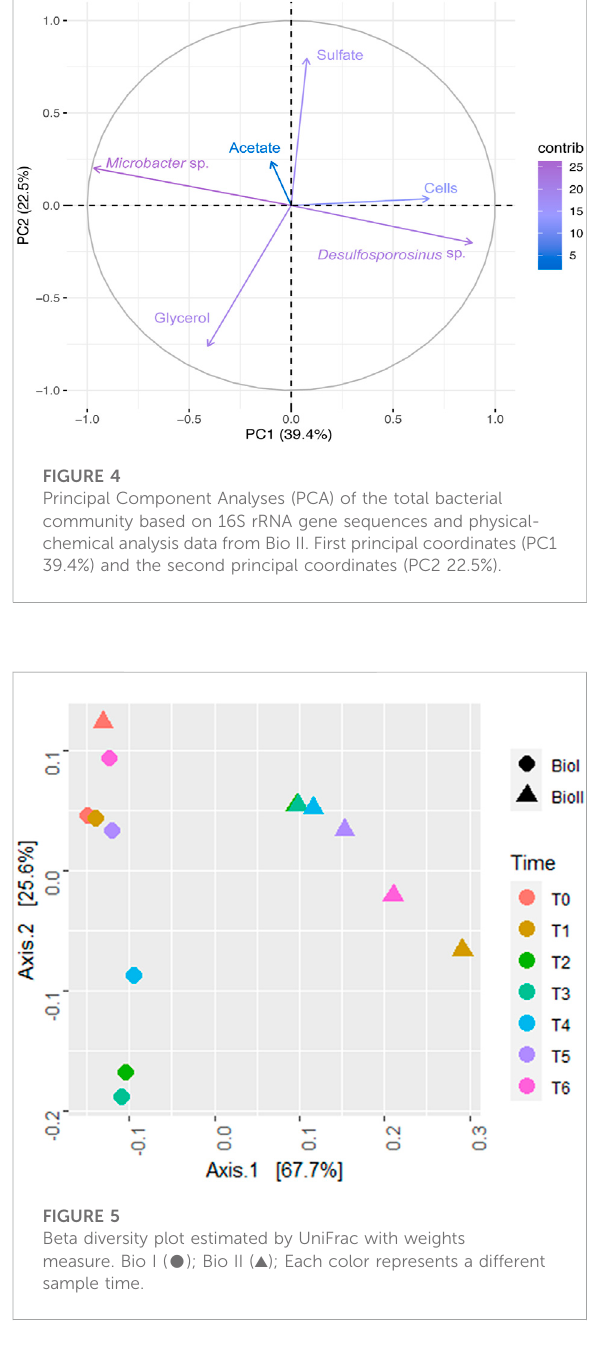
Beta diversity obtained by the weighted (quantitative) UniFrac distance (Figure 5) shows two clusters separating the samples by bioreactor. Only the inoculum sample (T0) from Bio II was grouped with the Bio I cluster.